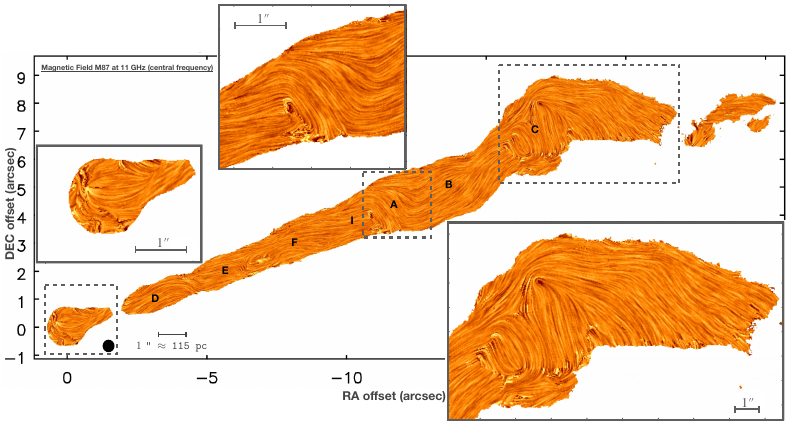
Figure 4. Line integral convolution (LIC) map of the sky-projected magnetic field orientation of M87 and zooms of the core, knot A and knot